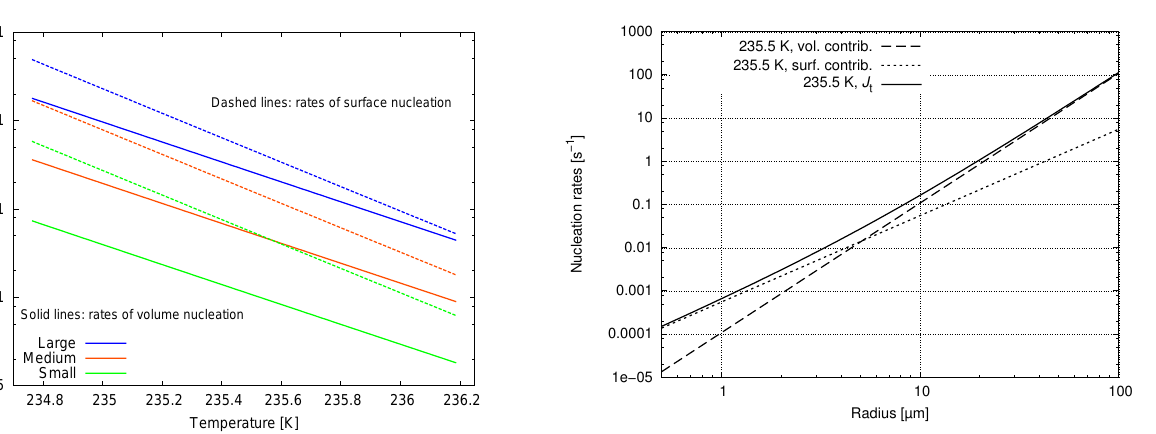
Fig. 2. Nucleation rates resulting from fits including both volume and surface freezing. Contributions to nucleation rates from volume and surface processes are shown separately for each of the three droplet sizes. For each size, the surface nucleation rate is greater than the volume rate. This difference increases with decreasing droplet size, as expected from the different radius dependence of surface and volume nucleation rates.